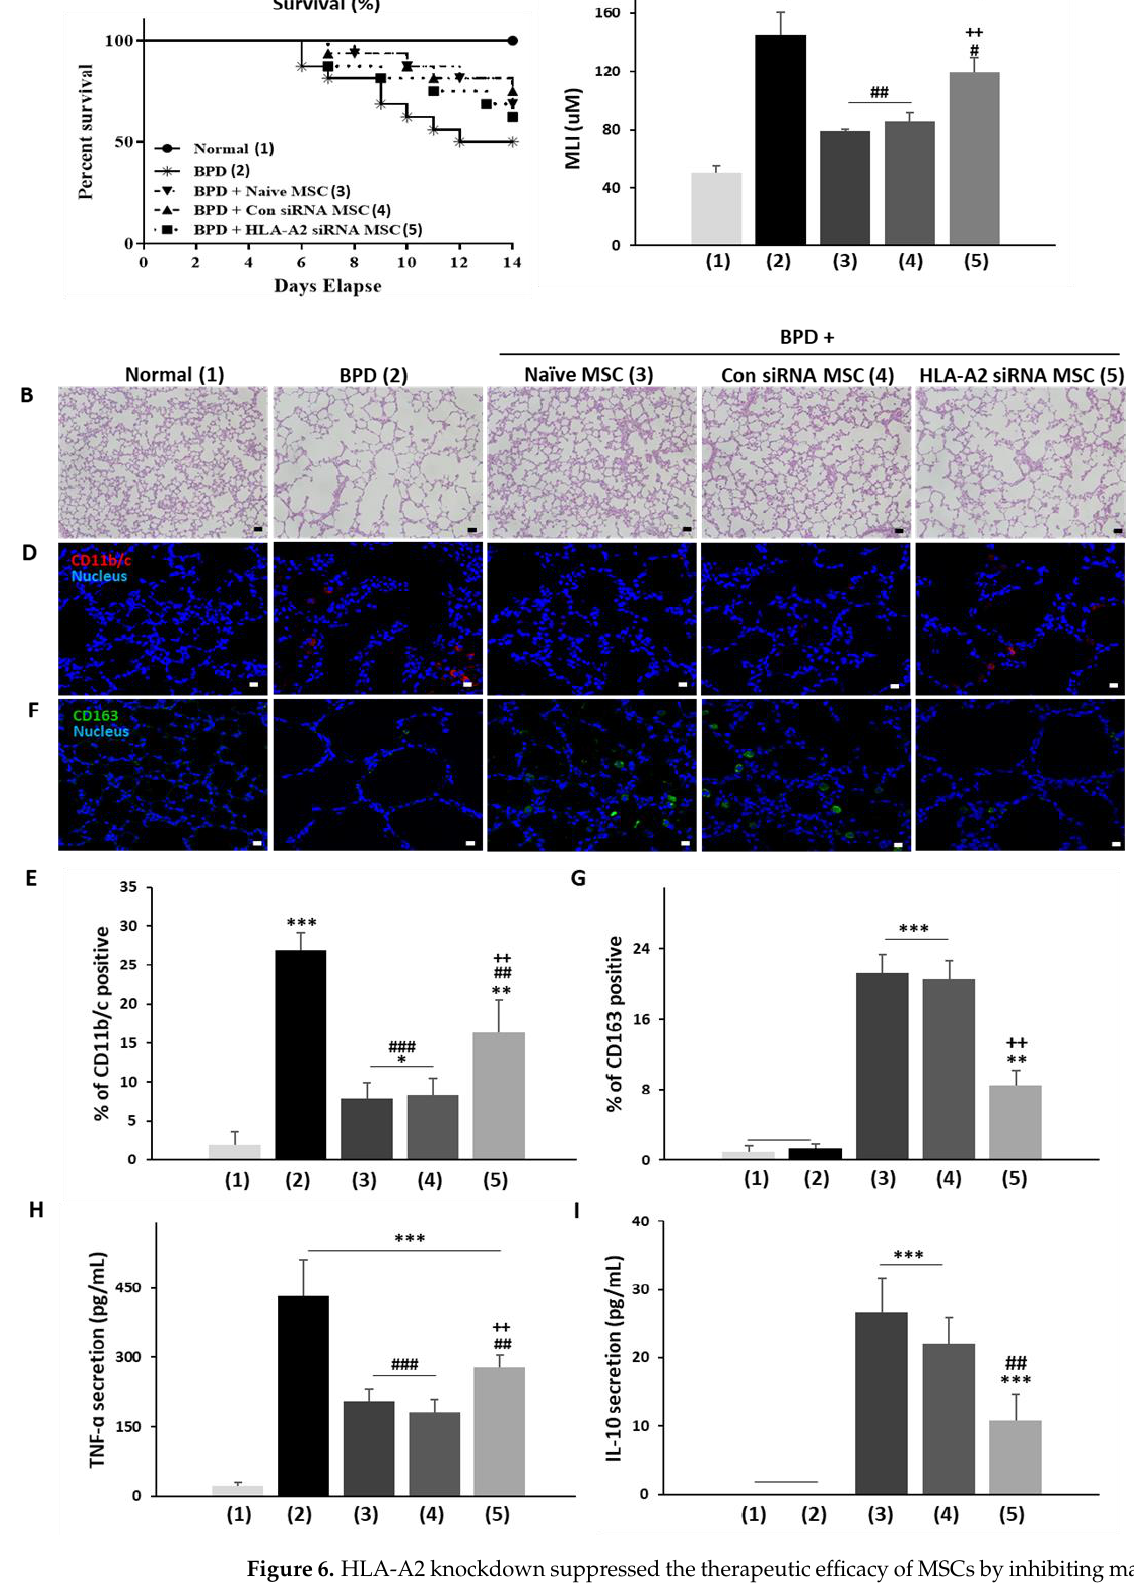
Figure 6. HLA-A2 knockdown suppressed the therapeutic efficacy of MSCs by inhibiting macrophage polarization. HLA-A2 siRNA-treated MSCs were intratracheally injected in BPD rats. ( A ) HLA-A2 siRNA-transfected MSCs were intratracheally injected on Day 5. Daily survival rates during a 14-day period from birth are presented as Kaplan – Meier survival curves. Lung tissues ob- tained on Day 14 were compared with those from the control group (Normal). ( B ) The mean linear intercept (MLI) values were evaluated by the degree of alveolarization. ( C ) Lung tissues were sec- tioned and stained with H&E. Results are presented as the mean ± SD for n = 11 (Normal), n = 15 (BPD, BPD with naïve MSC), or n = 14 (con siRNA MSCs, HLA-A2 siRNA MSCs) per group. ( D , F ) Immunofluorescence analysis for ( D ) CD11b/c or ( F ) CD163 in lung tissues. ( D ) Nuclei were stained with Hoechst 33342 (blue). Red (CD11b) and green (CD163) staining indicates positive cells. Scale